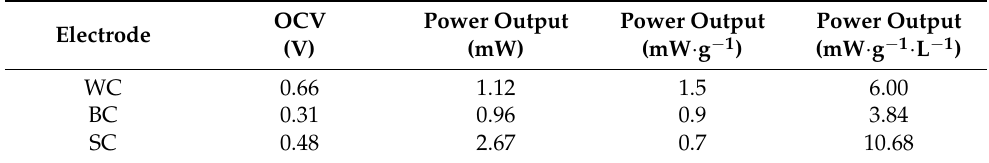
Table 3. OCV and maximum power output values obtained from the leachate-fed MFC with the three different electrode cases examined.